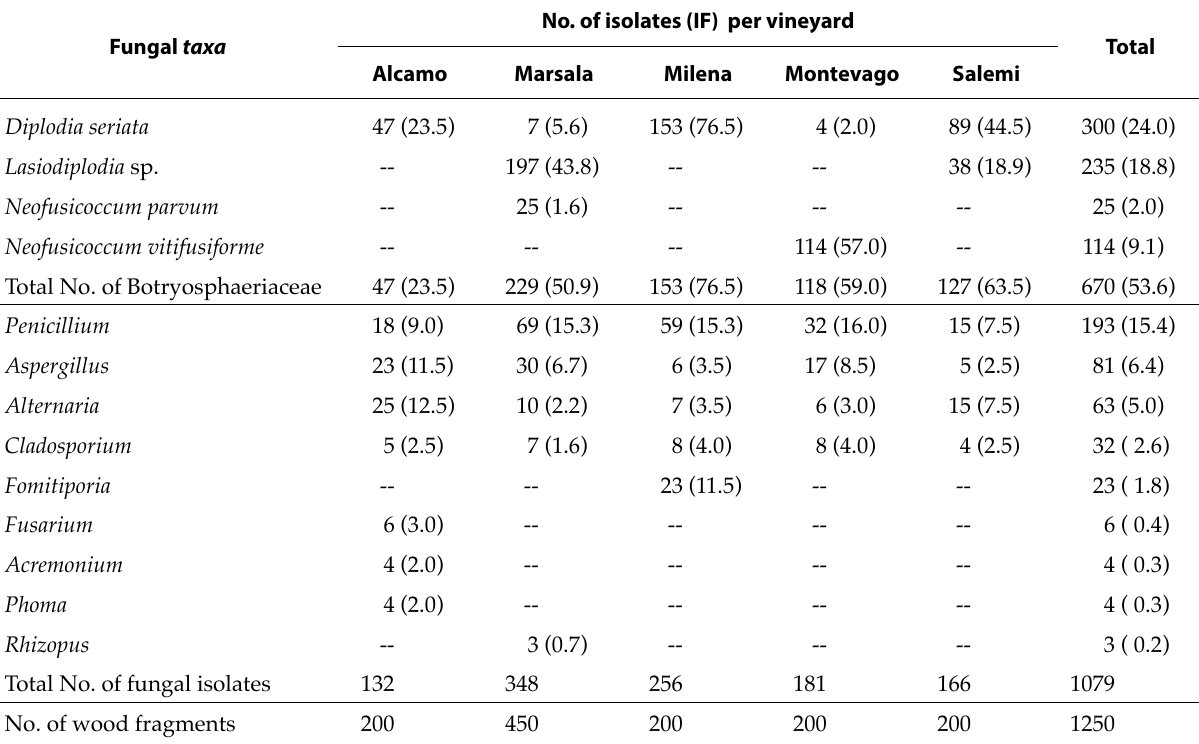
Table 1. Number of isolates and isolation frequency (IF) of the Botryosphaeriaceae species and other fungal taxa obtained from symptomatic wood of diseased grapevines in